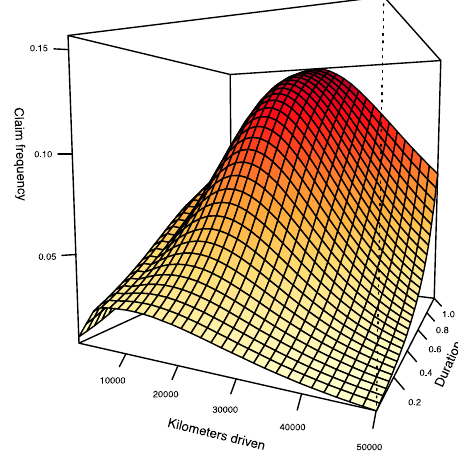
Figure 10. Model 2—Predictions surface (angle 2).